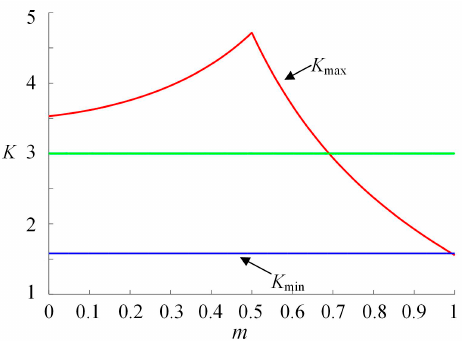
Figure 7. Region of K with variable T d ( T d = mT s , 0 ≤ m ≤ 1).